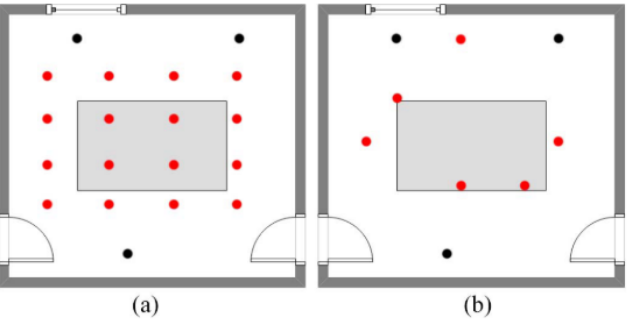
Figure 3. The environment of scenario 2. ( a ) Training data points. ( b ) Testing data points. The three black dots are AP locations, and the red dots are measuring points.